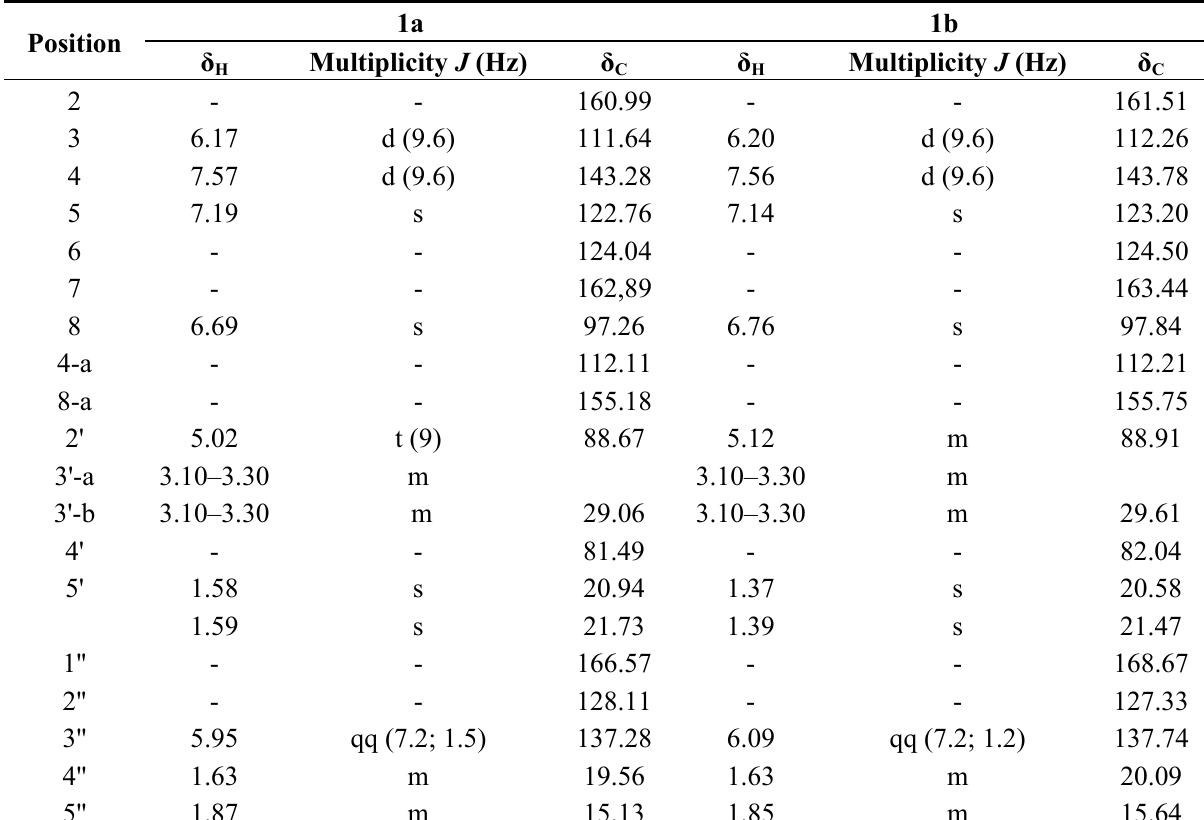
Table 2. 1 H- and 13 C-NMR spectroscopic data of the two diastereoisomers ( 1a and 1b ).